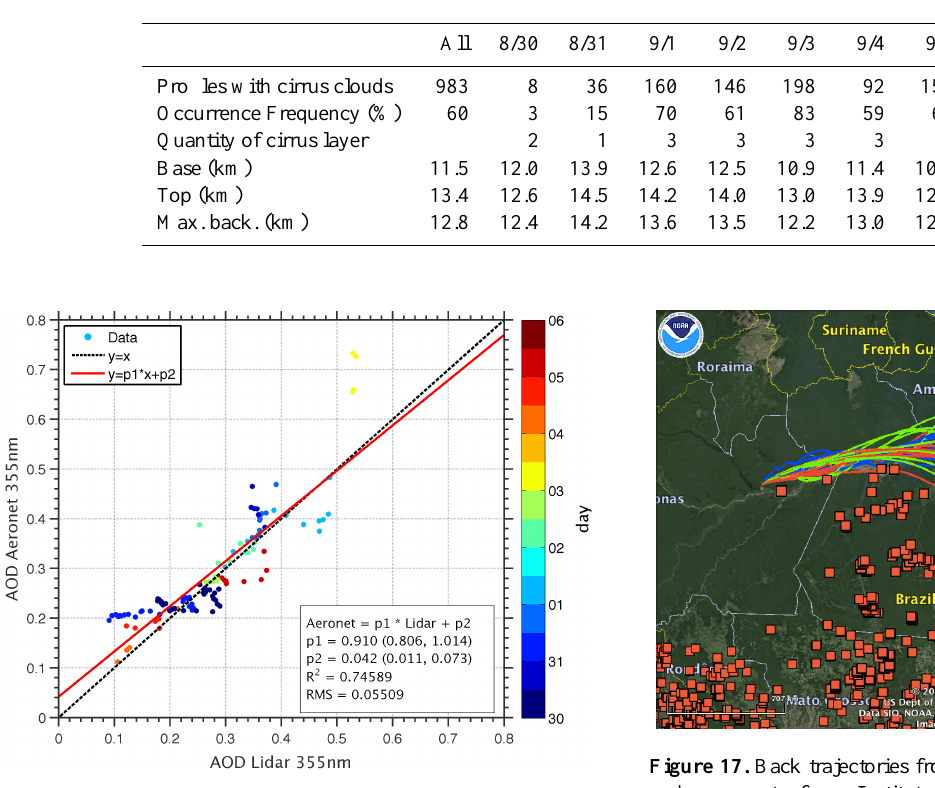
Table 1. Average geometrical characteristics (base, top and maximum backscattering height) and frequency of occurrence of cirrus clouds in the measurement site near Manaus city during 30 August and 7 September 2011.